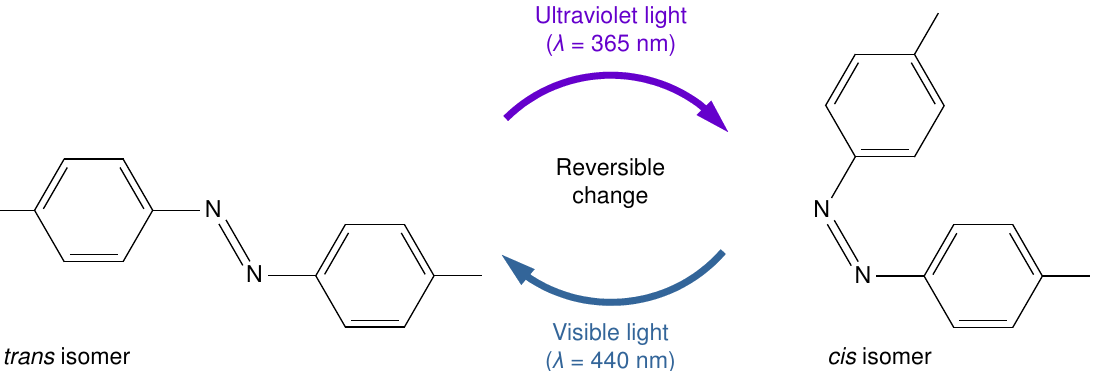
Figure 1. Schematic diagram of the photochemical isomerization, reproduced on the basis of Ref. [23]. The cis isomer irradiated with visible light should change into the trans isomer, while the trans isomer irradiated with ultraviolet (UV) light would change into the cis isomer. These two isomers may exhibit different fluid properties. The rate at which the number of isomers increases or decreases by photo-induced isomerization is expressed as a reaction rate constant k